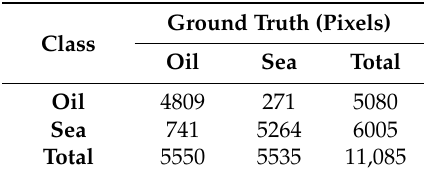
Table 14. Confusion matrix achieved by SVM based on four features derived from ISOMAP on quad-pol SAR